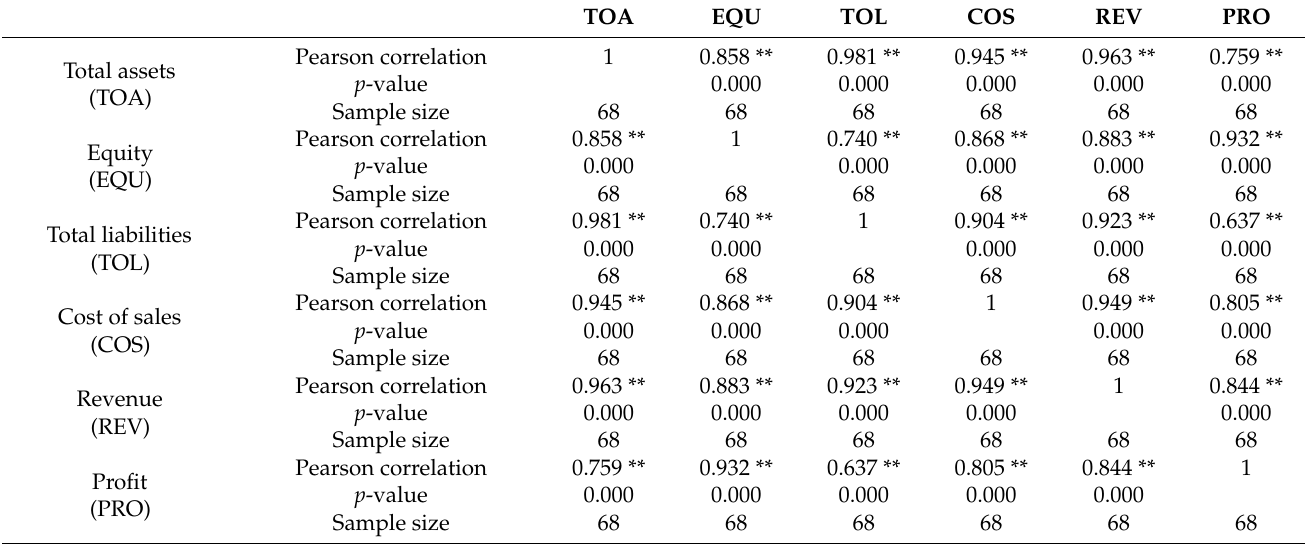
Table 5. Correlation coefficient